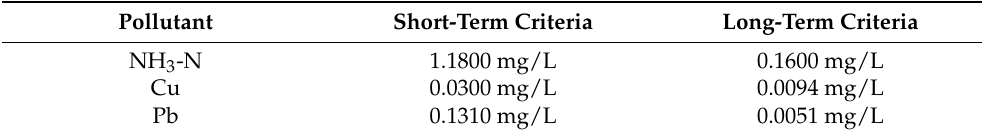
Table 1. Water quality safety criteria of NH 3 -N, Cu, and